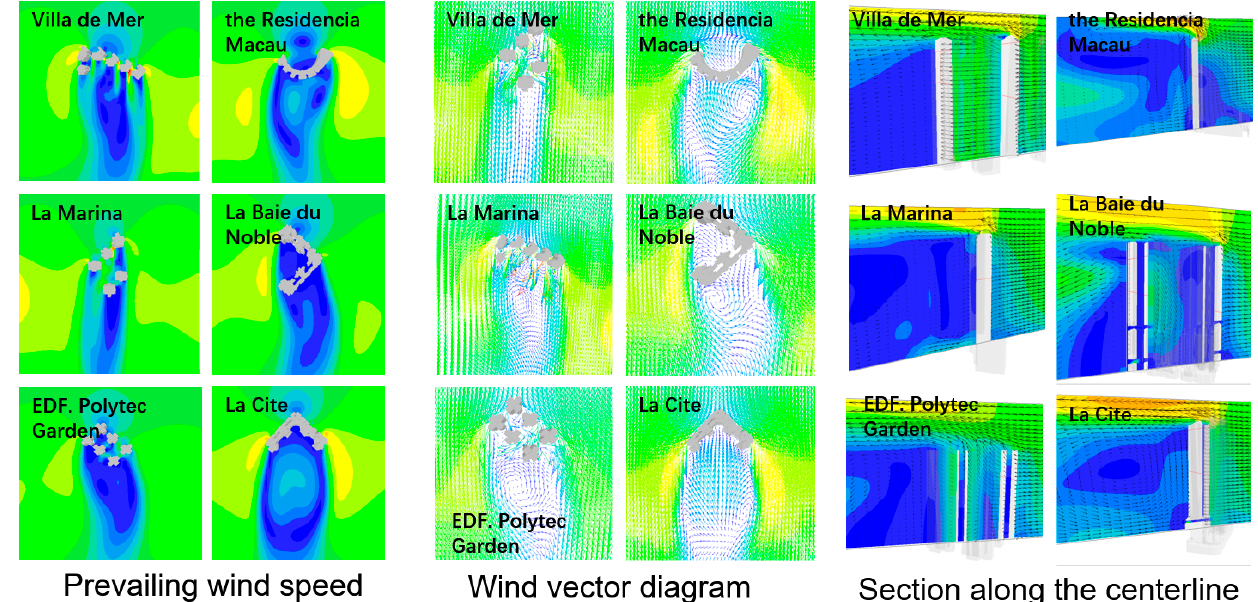
Figure A7. Wind field simulation